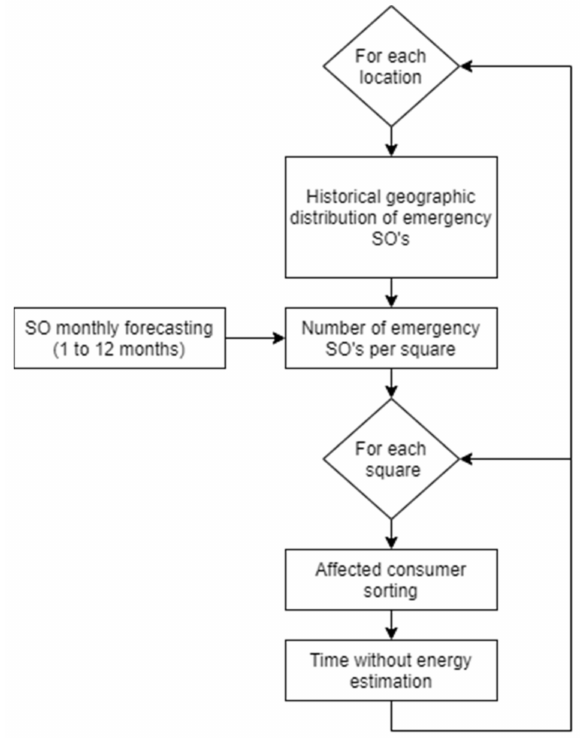
Figure 2. Emergency service orders distribution and individual time without energy